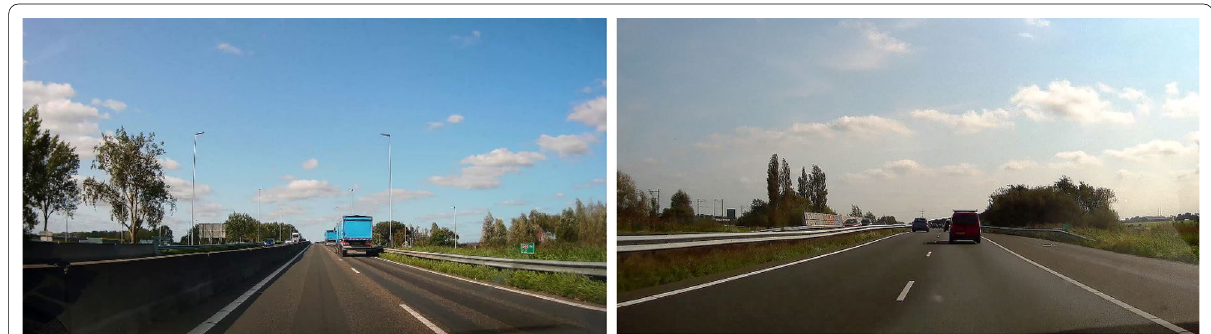
Fig. 2 Examples of roads in the Netherlands that are difficult to categorize. On the left is a picture of a motorway/freeway (A44) without crossing traffic, with no slow moving vehicles, and expected speeds of 100 km/h (daytime) and 120 km/h (nighttime); while on the right is an expressway (N11) where traffic lights, traffic that is crossing (including bicyclists) and stopped vehicles can be expected while the maximum speed is 100 km/h. Because the roads look similar people categorize them as being the same, and will behave the same even though officially these are different types of roads (see Theeuwes and Diks